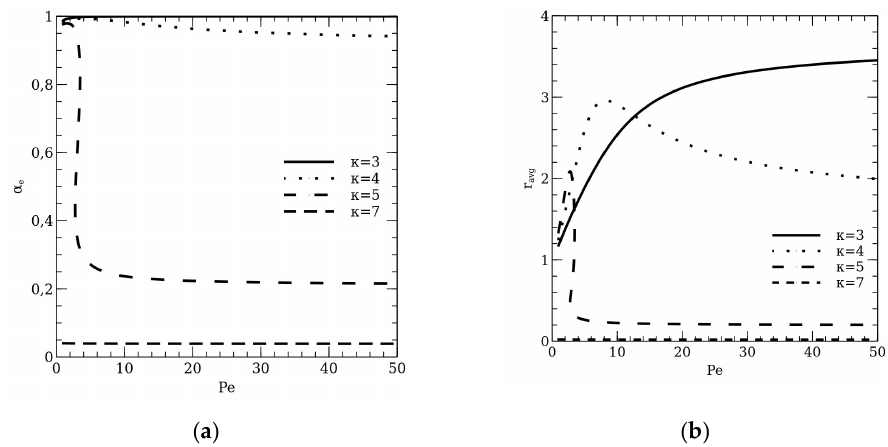
Figure 6. The branches of steady states versus the Peclet number for different absorbances. Two different quantities have